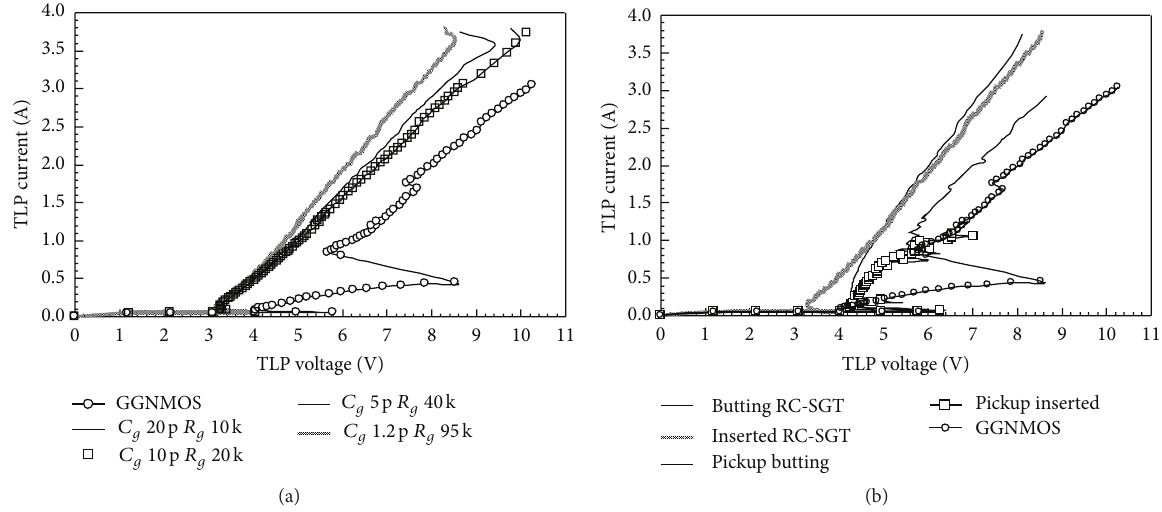
Figure 4: (a) The TLP 𝐼 - 𝑉 curve comparison among the GGNMOS and RC SGTNMOS with normal pickup style. (b) The TLP 𝐼 - 𝑉 curve comparison among the GGNMOS and RC SGTNMOS with special pickup styles.